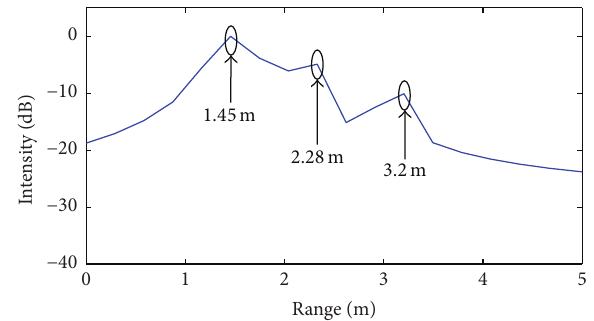
Figure 8: Range profile obtained from standard IFT algorithm (second scenario: 𝑁 = 6 targets).